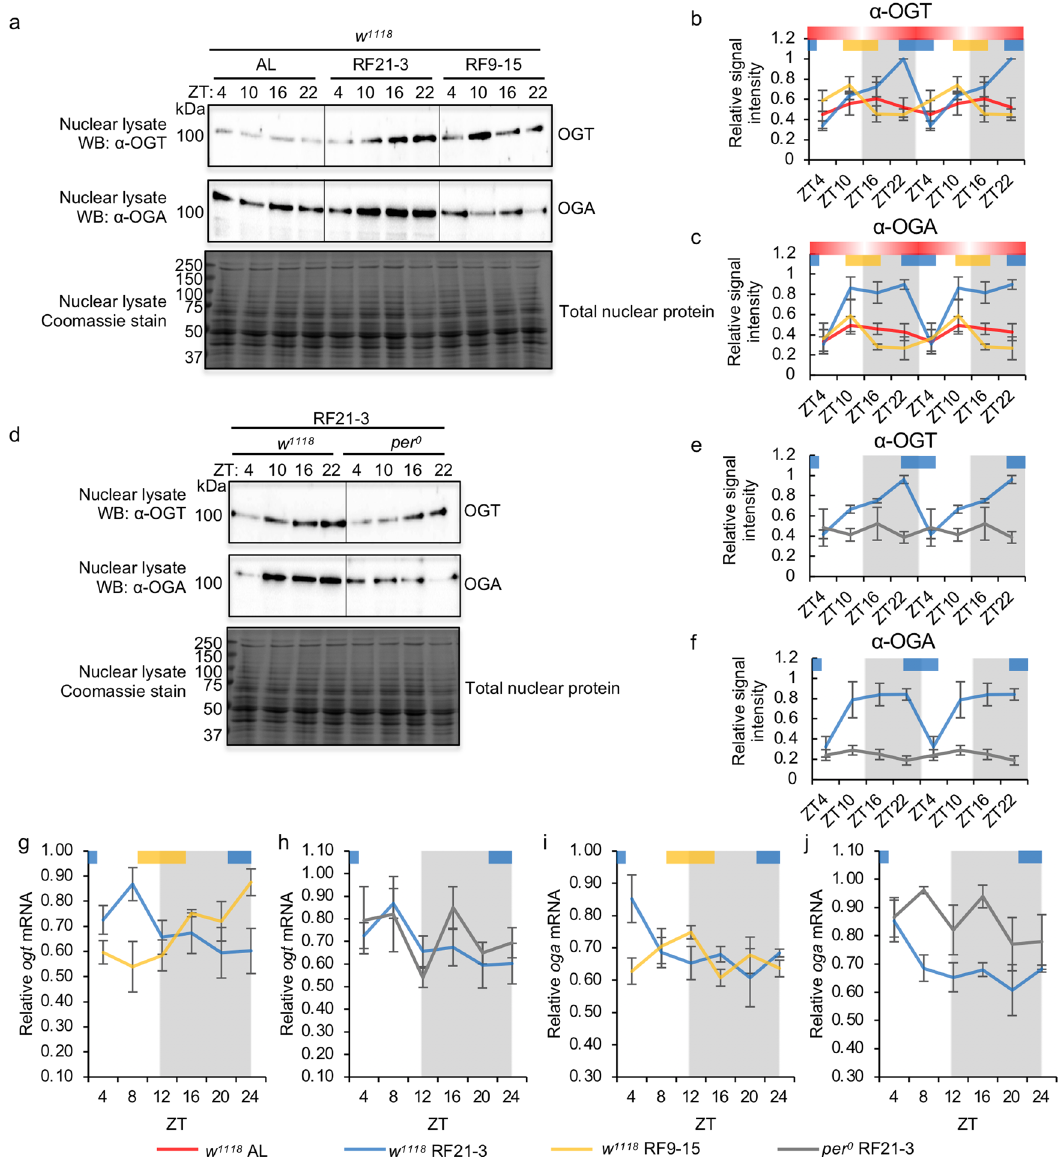
Fig. 5 The molecular clock and the timing of food consumption regulate OGT and OGA protein levels. a Western blots showing daily rhythms of OGT (top panel) and OGA protein (middle panel) in WT fl ies ( w 1118 ) fed ad libtum , between ZT21-3 (natural feeding time), or between ZT9-15 (unnatural feeding time). Total nuclear proteins stained by Coomassie blue (bottom panel) were used for normalization. Each biological replicate was performed independently with similar results ( n = 4). b , c Quanti fi cation of daily OGT protein rhythm ( n = 4; AL: p = 0.62, RF21-3: p = 3.92E − 06, RF9-15: p = 0.036, RAIN; WT RF21-3 vs RF9-15: mesor p = 0.075, amplitude p = 0.25, phase p = 3.56E − 06, CircaCompare) and OGA protein rhythm ( n = 4; AL: p = 0.92, RF21-3: p = 0.051, RF9-15: p = 0.31; RAIN). d Western blots showing daily rhythms in OGT (top panel) and OGA protein (middle panel) in WT ( w 1118 ) and per 0 fl ies fed between ZT21-3. Each biological replicate was performed independently with similar results ( n = 4). e , f Quanti fi cation of OGT ( n = 4; WT: p = 5.63E − 07, per 0 : p = 0.68, RAIN) and OGA protein levels ( n = 4; WT: p = 0.038, per 0 : p = 0.41, RAIN). Data are double plotted. g , h Expression of ogt mRNA in three groups of fl ies: WT RF21-3, per 0 RF21-3, and WT RF9-15. ( n = 3; WT RF21-3: p = 0.041, WT RF9-15: p = 0.0033, per 0 RF21-3: p = 0.94, RAIN; WT RF21-3 vs RF9-15: mesor p = 0.84, amplitude p = 0.60, phase p = 2.36E − 06, CircaCompare). i , j Expression of oga mRNA in three groups of fl ies: WT RF21-3, per 0 RF21-3, and WT RF9-15. ( n = 3; WT RF21-3: p = 0.044, WT RF9-15: p = 0.22, per 0 RF21-3: p = 0.53; RAIN). The biological replicates of WT RF21-3 that are quanti fi ed in panel ( h ) and ( j ) are the same three replicates quanti fi ed in panel ( g ) and ( i ) respectively. Gray shading indicates the dark period of LD cycle. Colored bars at the top of graphs denote the feeding periods for TRF treatment groups, RF21-3 (blue) and RF9-15 (yellow). The red bars with gradient shading illustrate the representative feeding pattern for AL fl ies (data depicted from Fig. 2a), and the darker area indicates higher feeding activity. Data are normalized (peak = 1) and are presented as mean ± These results suggest that timing of nutrient input can impact the amplitude and phase of OGT protein rhythm in the presence of (Fig. 5a, b). In WT fl ies fed at unnatural feeding time (RF9-15), an intact molecular clock. In per 0 RF21-3 fl ies, OGT protein level daily OGT protein rhythm was dampened and exhibited a phase was arrhythmic and remained low throughout the day-night cycle shift that corresponded with the shift in feeding time (Fig. 5a, b).